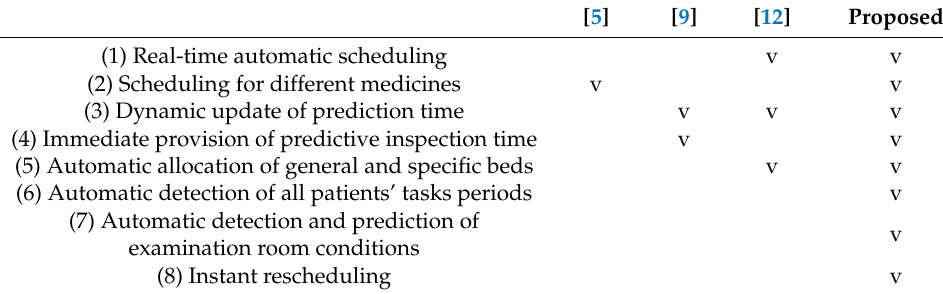
Table 7. Comparison of proposed and previous